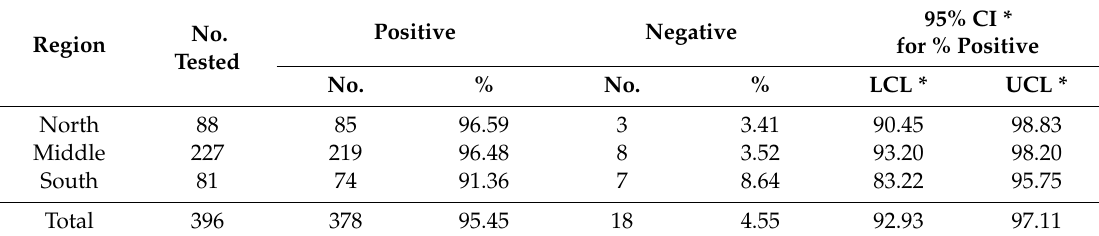
Table 2. The prevalence of human TTV in the North, Middle and South of